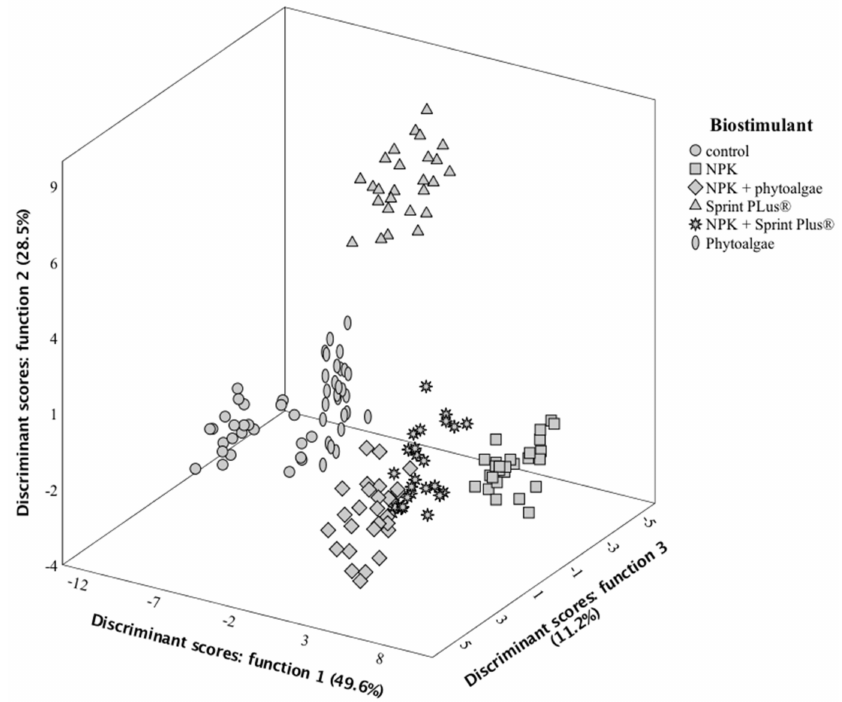
Figure 2. Spatial distribution of hazelnut crop biostimulant markers according to the discriminant functions coefficients. Function 1 accounted for 49.6% of the variation, function 2 accounted for 28.5%, while function 3 accounted for